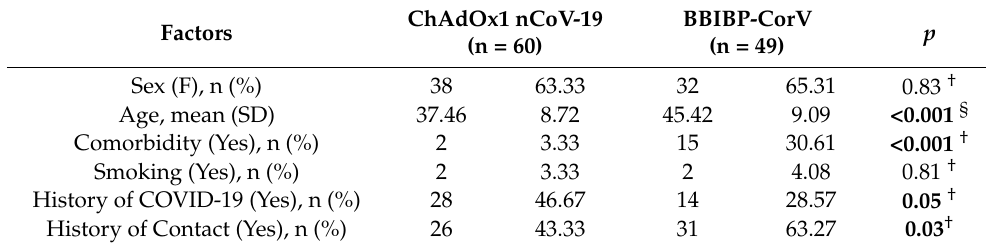
Table 1. Demographic and clinical characteristics of the participants (n = 109).